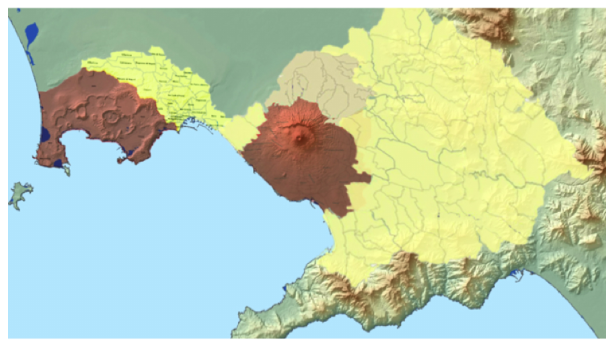
Figure 5. Red and yellow zones for Campi Flegrei and Vesuvius. Red zones are the areas with maximum pyroclastic flow hazard, which have to be completely evacuated within 72h from the decla- ration of “red alert”. Yellow zones are the areas with maximum haz- ard for accumulation of pyroclastic falls on flat roofs (see Vesuvius: http://www.protezionecivile.gov.it/documents/20182/0/mappa_